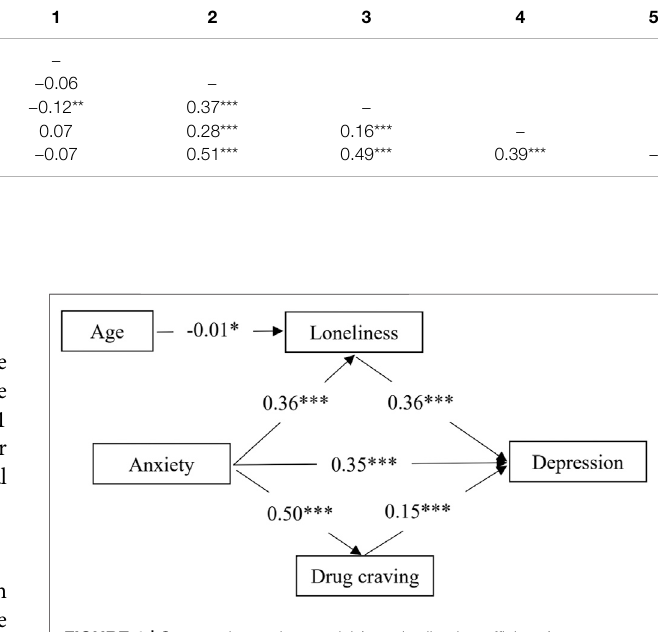
TABLE 3 | Intermediate effect bootstrap